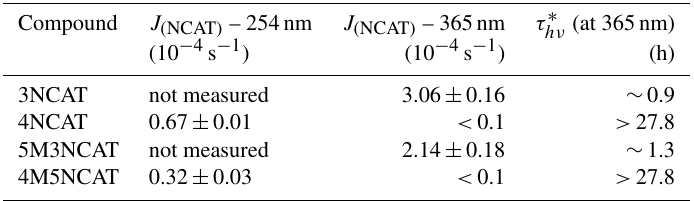
Table 2. Rate coefficient values for the photolysis of all nitrocatechols investigated in this study scaled to atmospheric conditions and their average atmospheric lifetimes owing to photolysis (at